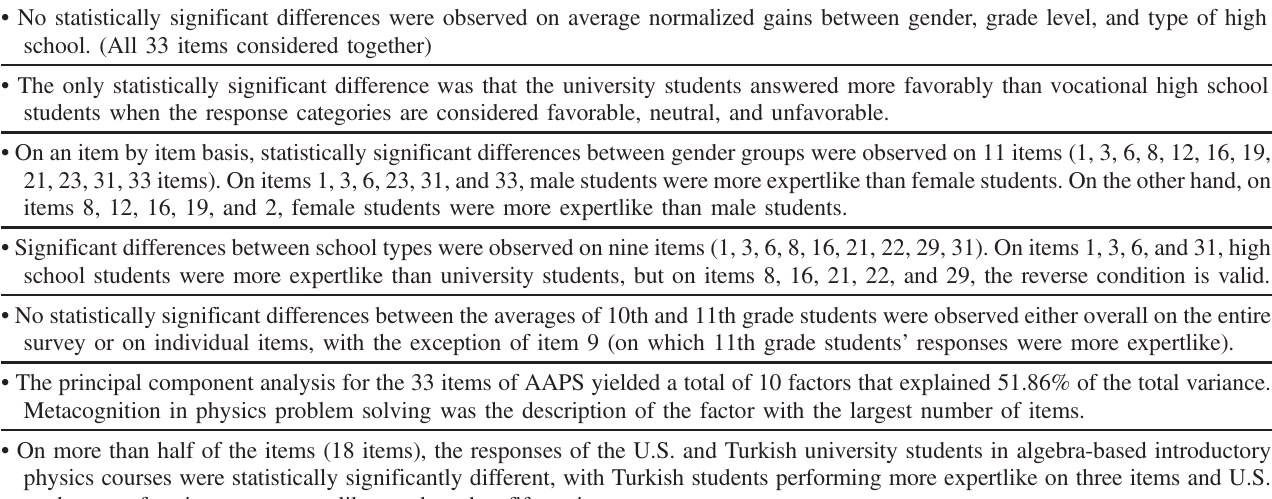
TABLE VI. Highlights of the main findings are summarized. • No statistically significant differences were observed on average normalized gains between gender, grade level, and type of high school. (All 33 items considered